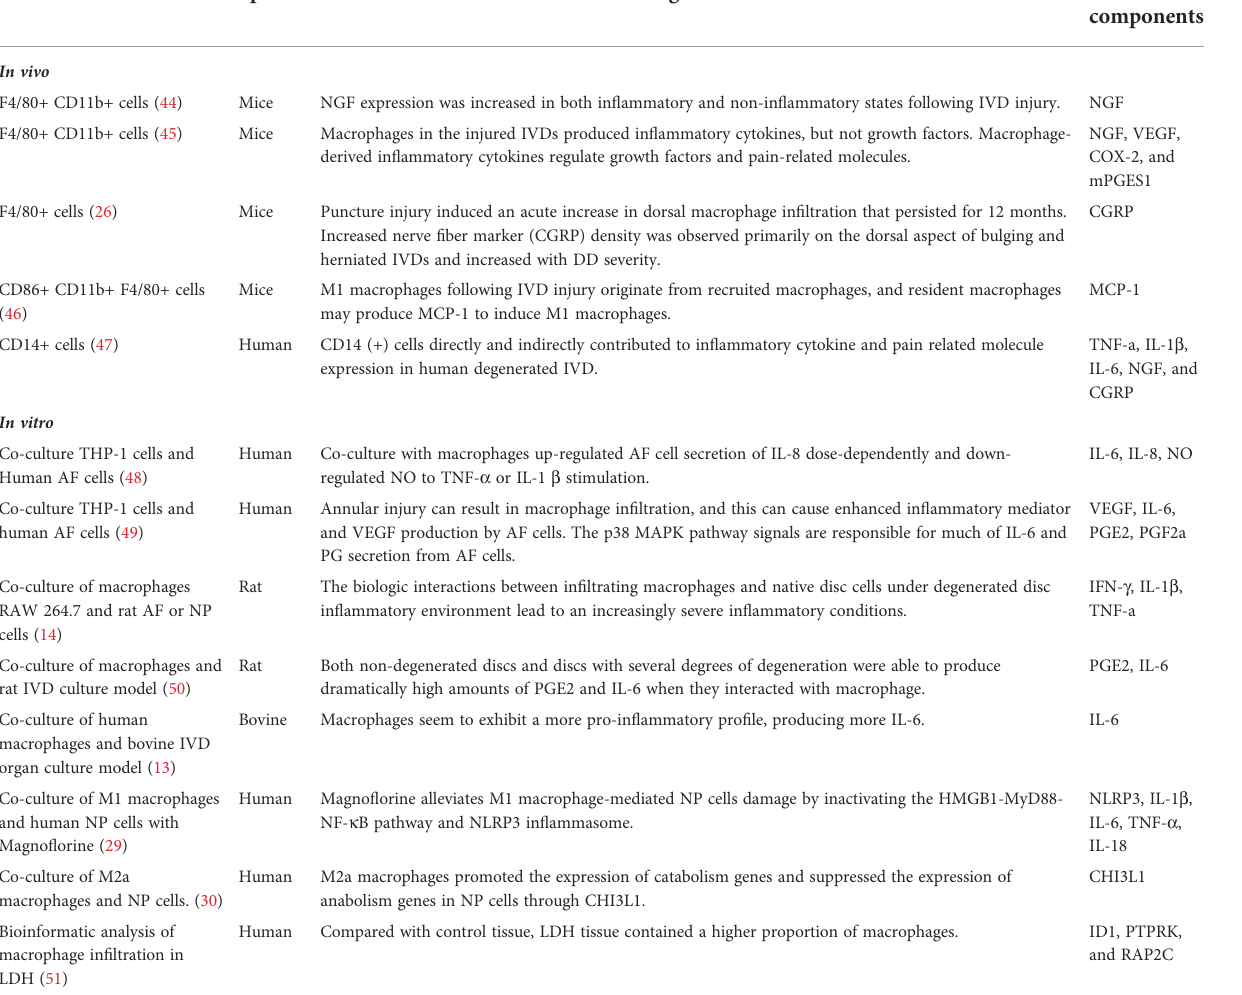
TABLE 3 Summary of the main biological effects and the main components of macrophages in IDD